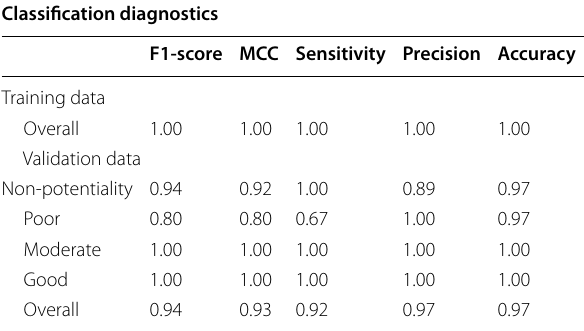
Table 5 RF model evaluation Classification